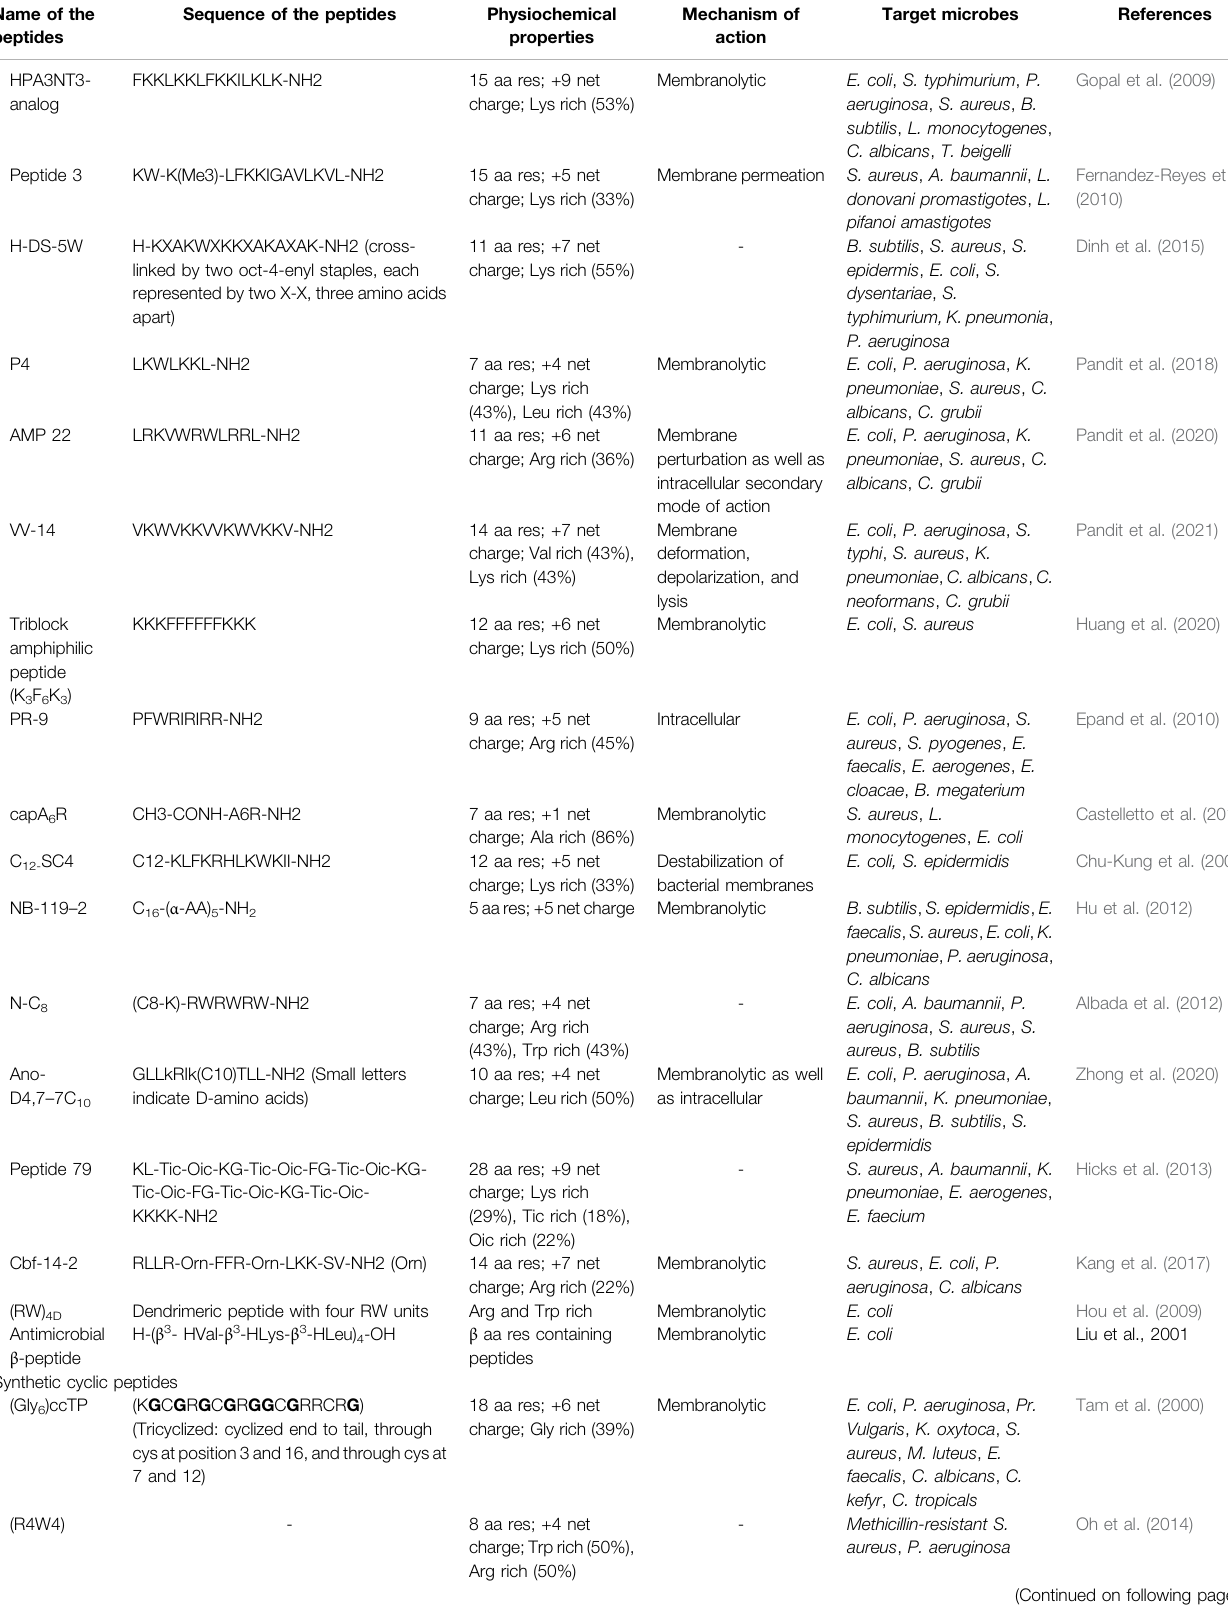
TABLE 2 | ( Continued ) Synthetic antimicrobial peptides (aa (cid:1) amino acid, res (cid:1) residues). Name of the